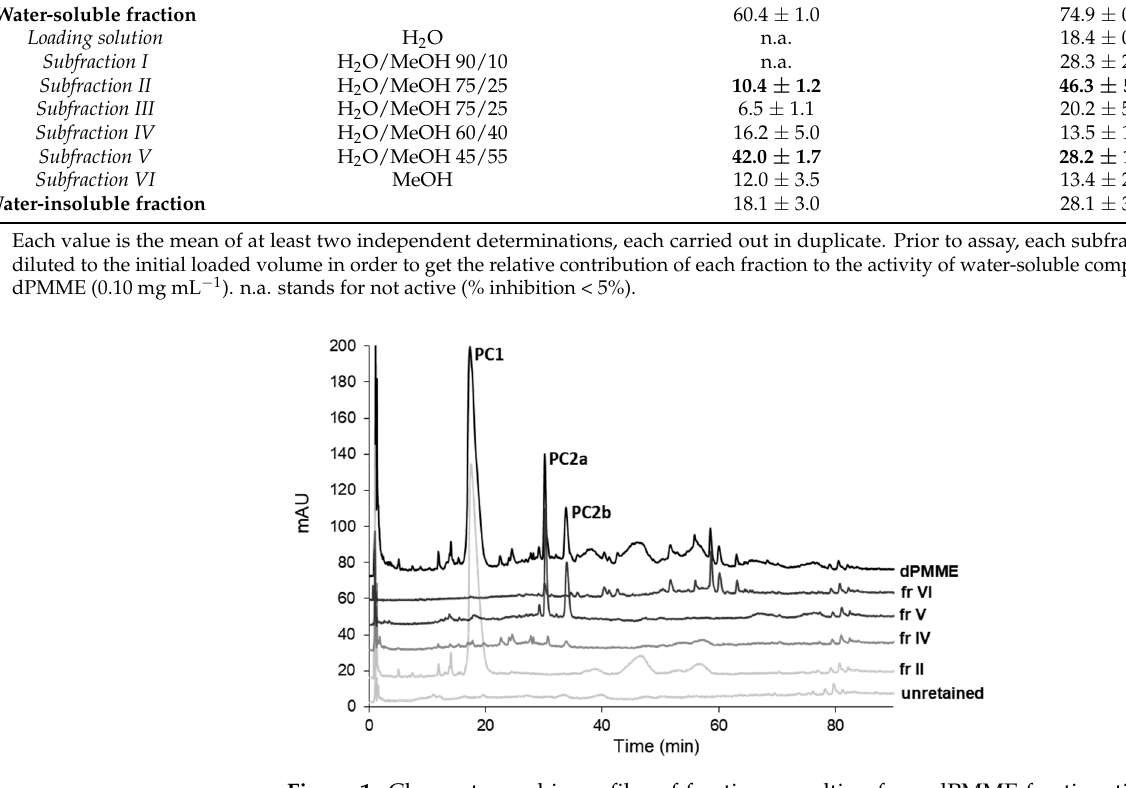
Figure 1. Chromatographic profiles of fractions resulting from dPMME fractionation by SPE on STRATA-X cartridges. Injection volume 20 µL; detection at λ = 220 nm; chromatographic conditions are as detailed in Section 3.6.